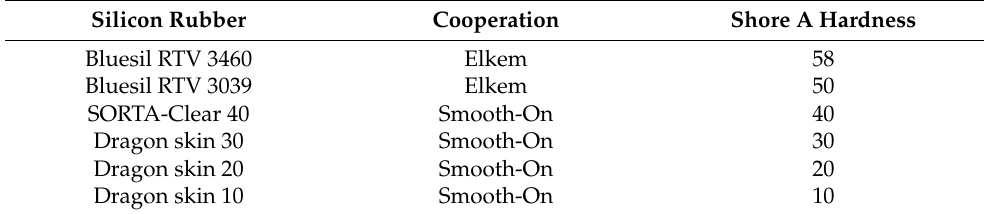
Table 3. Silicon rubbers that used in this